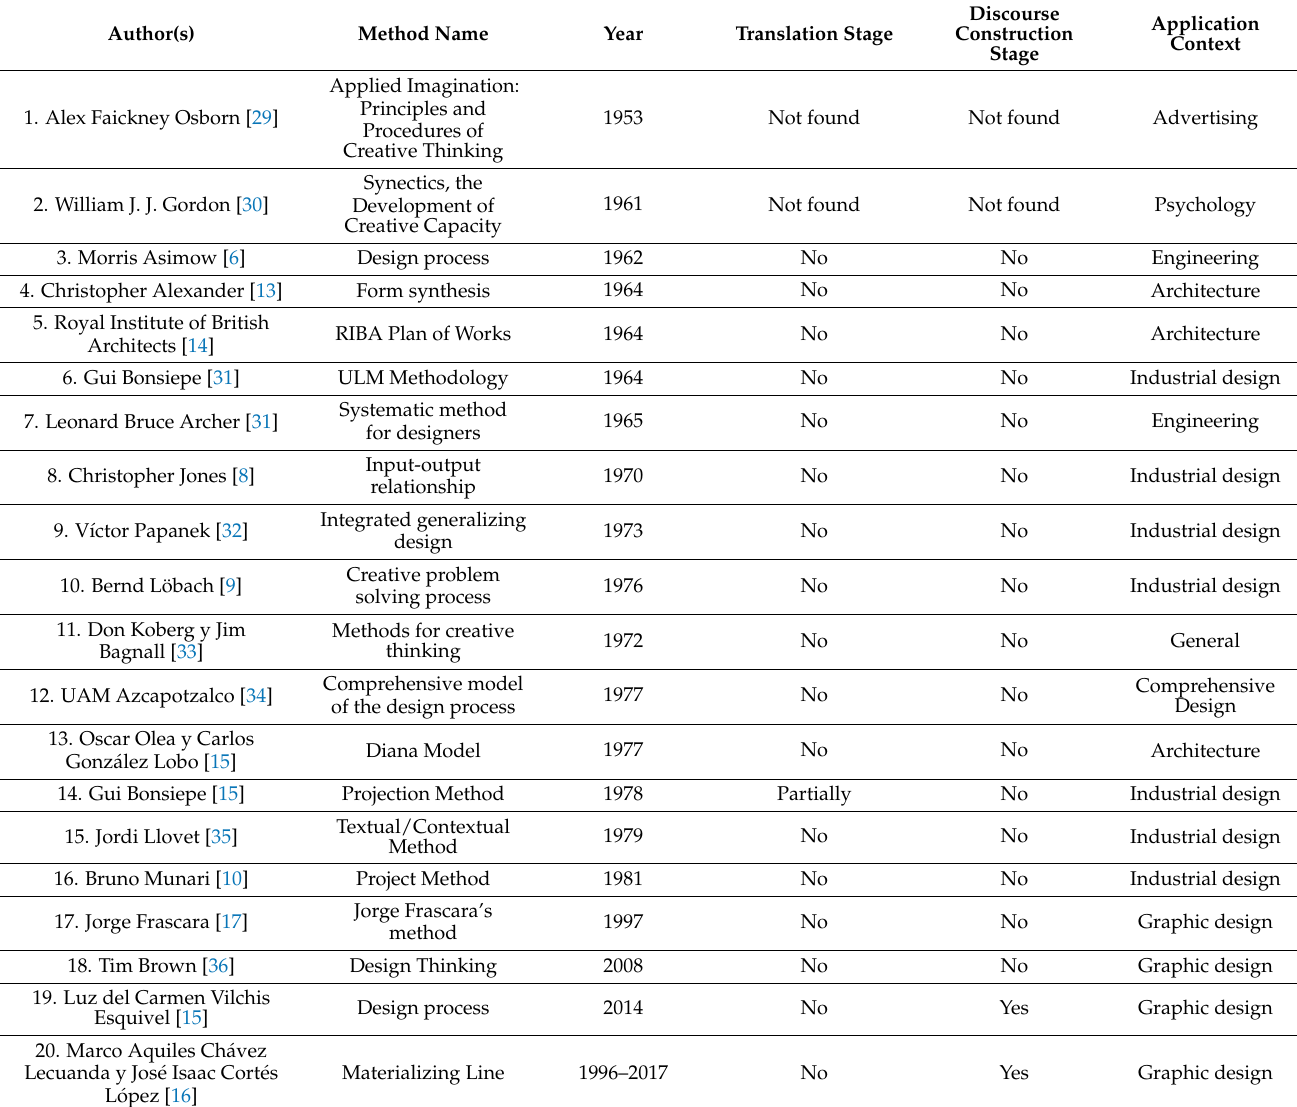
Table 2. Summary of design methods